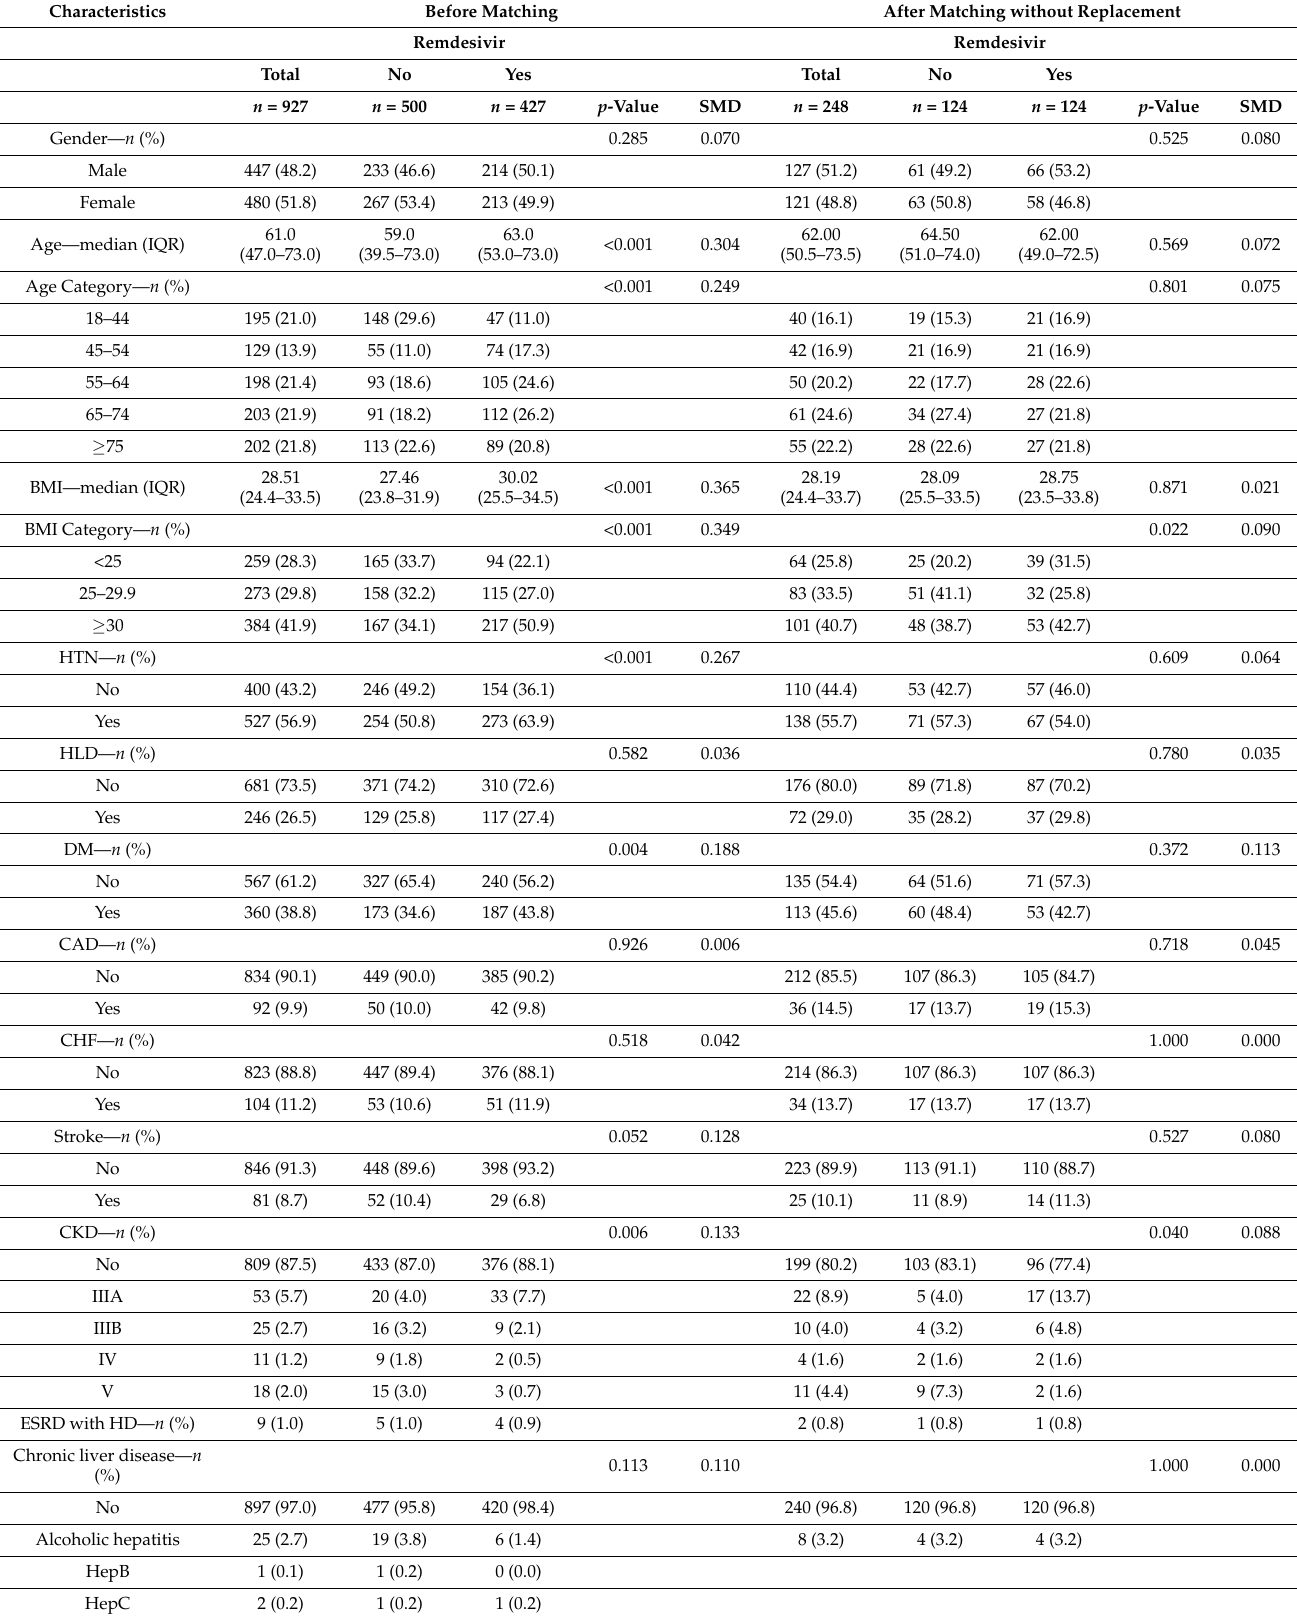
Table 1. Baseline Patient